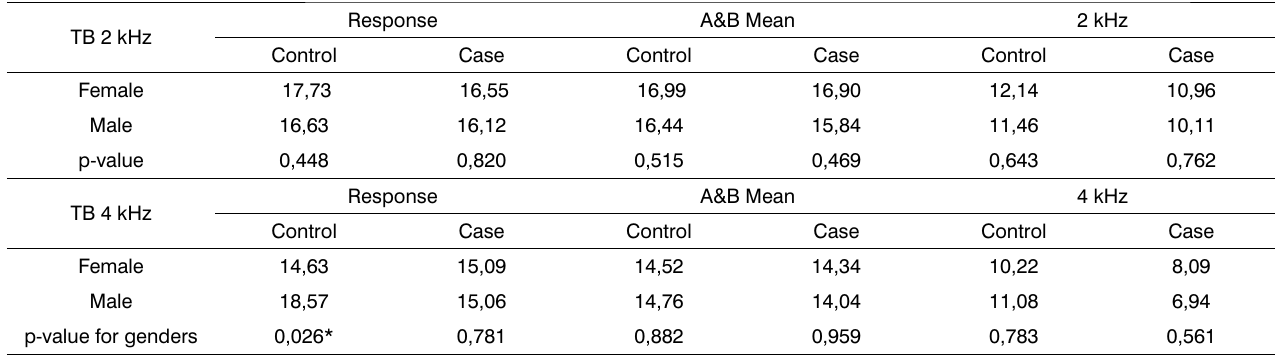
Table 5. Response magnitude (dB) and comparison (p-value) between